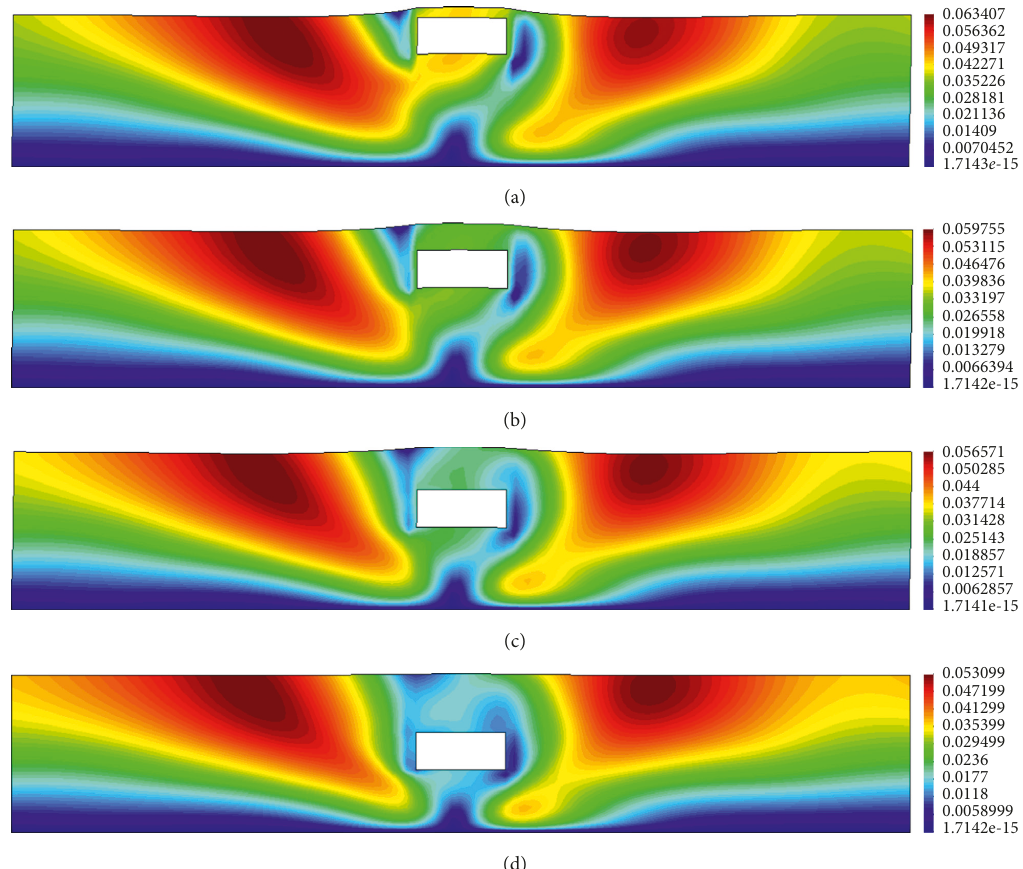
Figure 8: Contours of postearthquake residual displacement of soft soil ground with different burial depths (unit: (m): (a) 2m; (b) 5m; (c) 8m; (d) 11m.